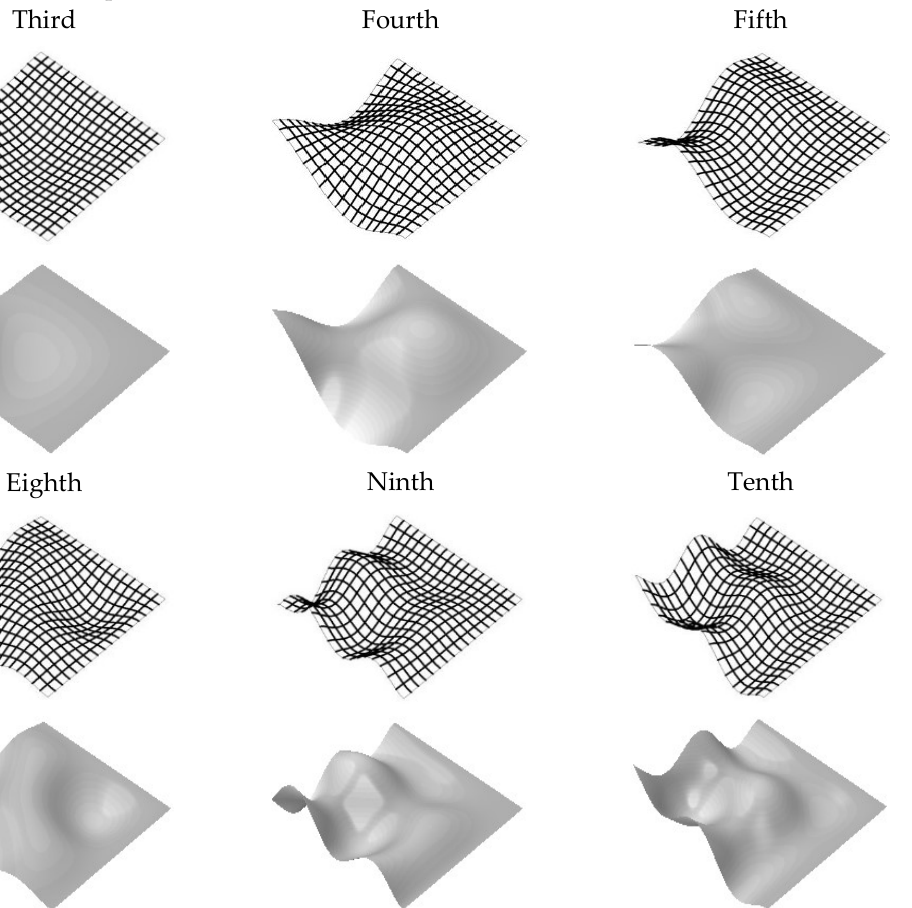
Figure 2. First ten mode shapes of the square CCFF plate with µ = 0.3, r x 0 = 0.999999 and r y 0 = 0.999999 .